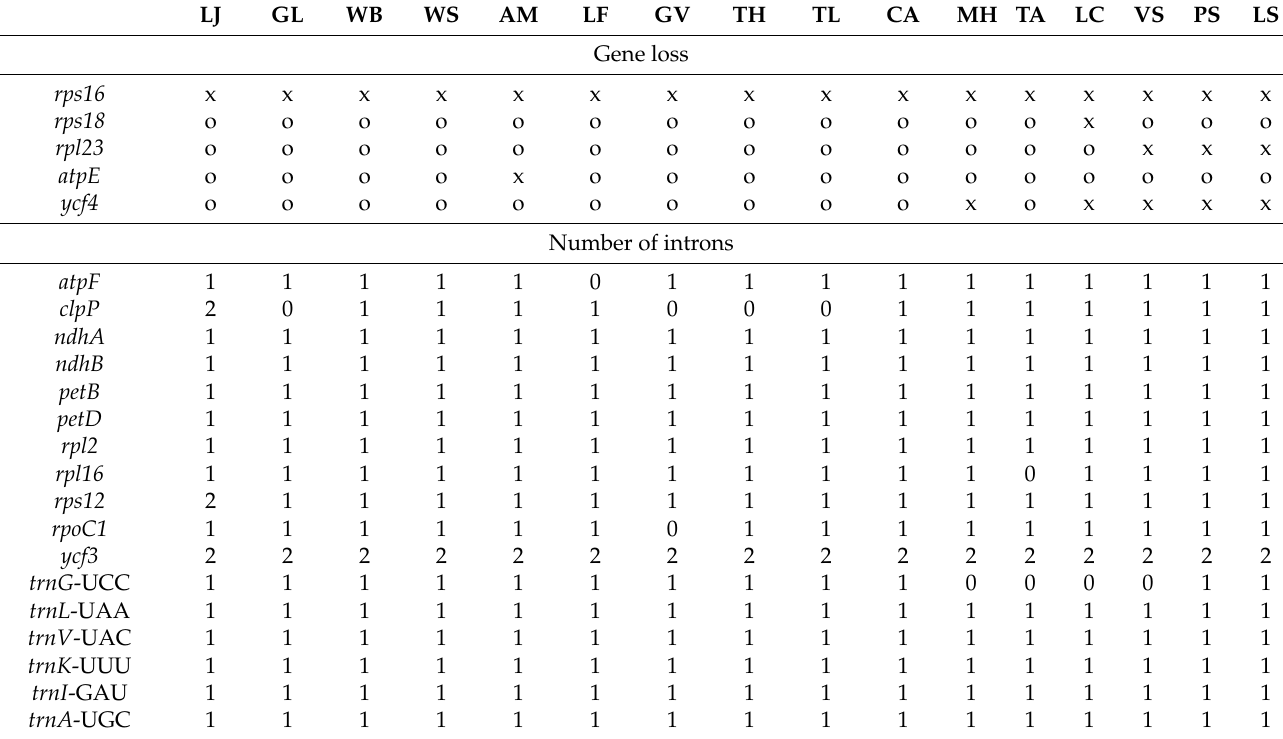
Table 2. Gene loss and number of introns of 15 IRLC species and 1 legume species (LS, Lotus japonicus